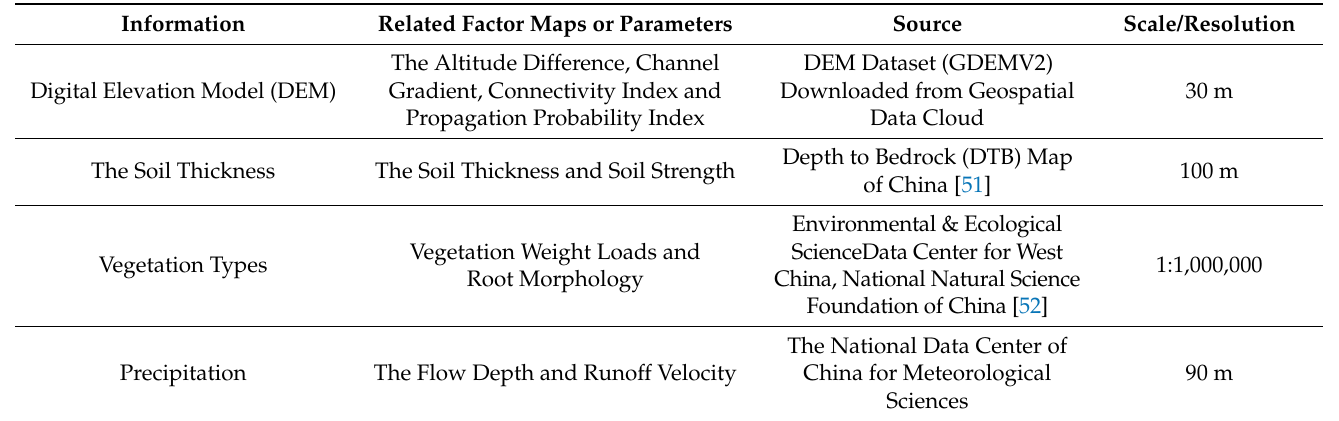
Figure 4. Susceptibility prediction index system sketch coupled with eco-hydrological activation. Table 1. Employed information and their sources in the current research.